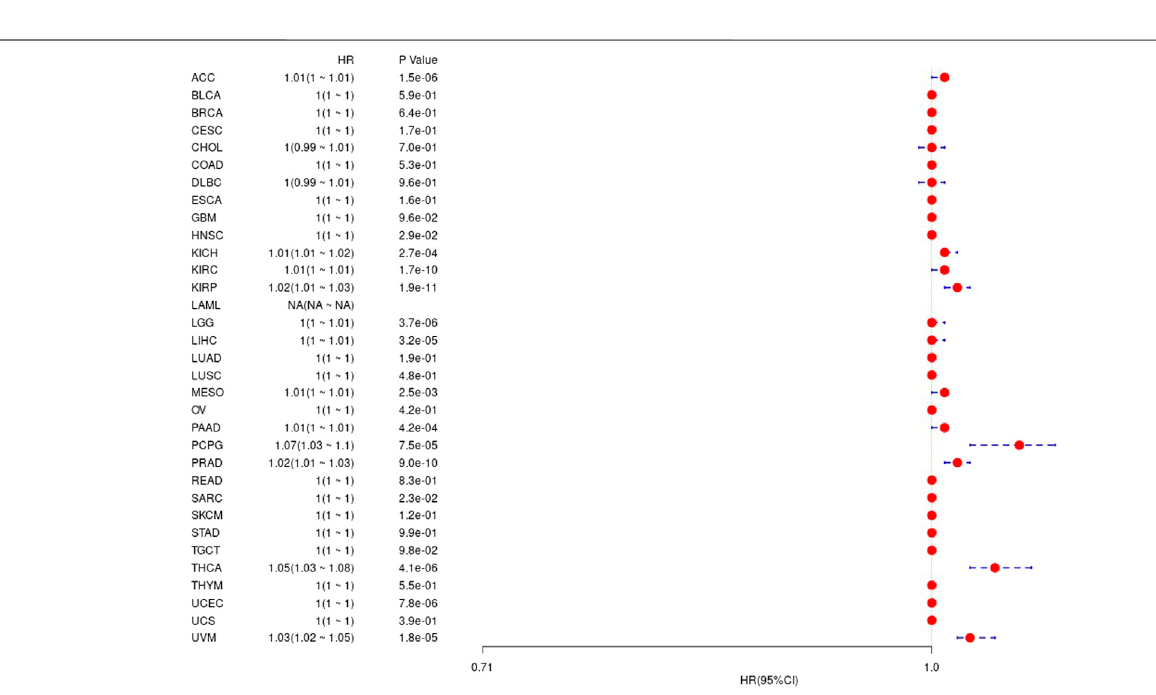
Frontiers in Genetics |